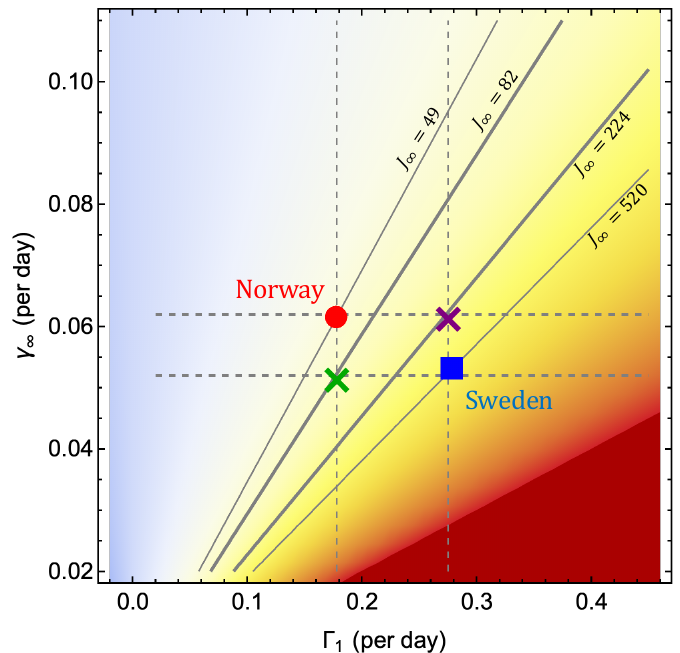
Figure 5. Density plot of J ∞ ( Γ 1 , γ ∞ ) with some isolines marked, along with the points for Sweden and Norway. The crosses mark the end states for paths where the inital and final phase of the two countries are